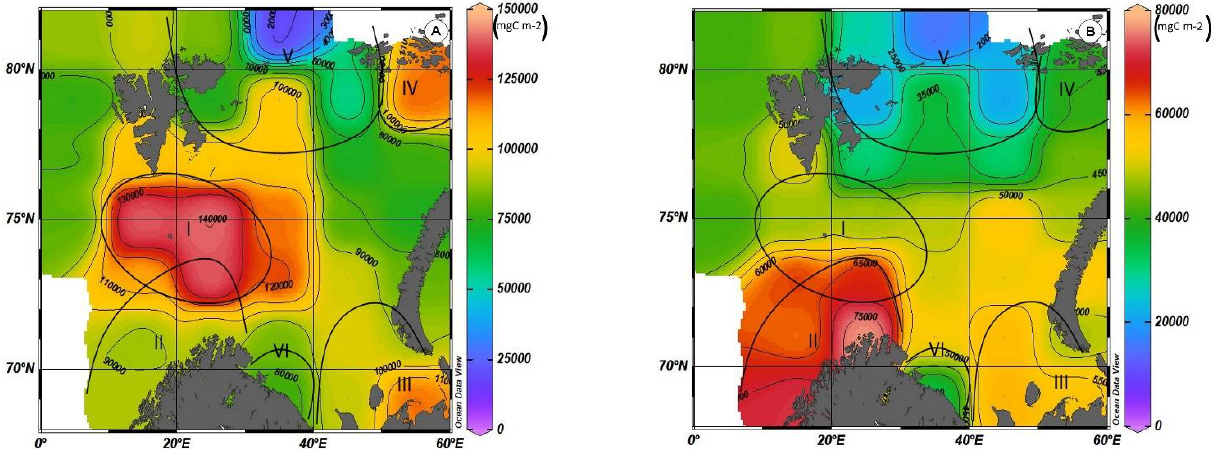
Figure 7. Estimated values of primary production (mg C m −2 ) for silicon ( A ) and nitrogen ( B ). Average values for the period from July to September. The numbers I to VI indicate the centers of regions with maximum or minimum values of primary production.